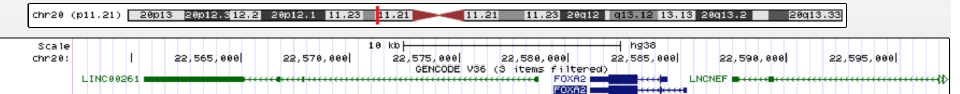
Figure 5. UCSC genome browser genomic location of the annotated lncRNA LINC00261 and FOXA2. LINC00261 and lncRNA neighboring enhancer of FOXA2 (LNCNEF)—green; FOXA2—dark